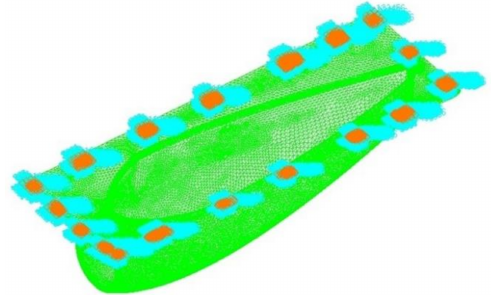
Figure 12. Boundary